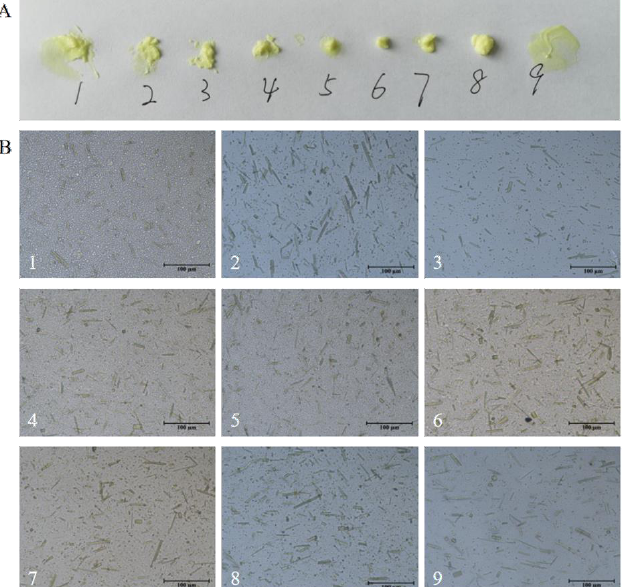
Figure 1. Appearances and particle sizes of the testing samples during formulation screening. ( A ) Nine prepared cream samples displayed differences in spreading. No. 1, 2, 5, and 9 were easy to spread, and others were relative sticky. ( B ) The distribution of the water phase, oil phase, and CA crystal were uniform, and no crystal with a size larger than 180 µ m was found in all